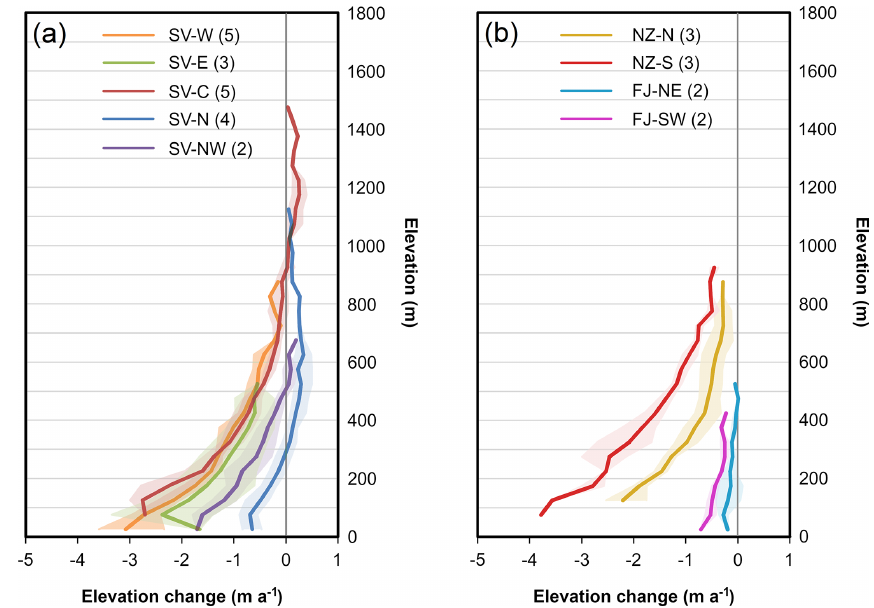
Figure 5. Relationships between glacier elevation change and altitude averaged over subregions for (a) Svalbard and (b) Novaya Zemlya and Franz Josef Land. Numbers in parentheses denote the number of sites within each subregion, while shading indicates minimum and maximum elevation change values at a given altitude within each subregion. For site-specific glacier elevation change curves and glacier hypsometry, see the